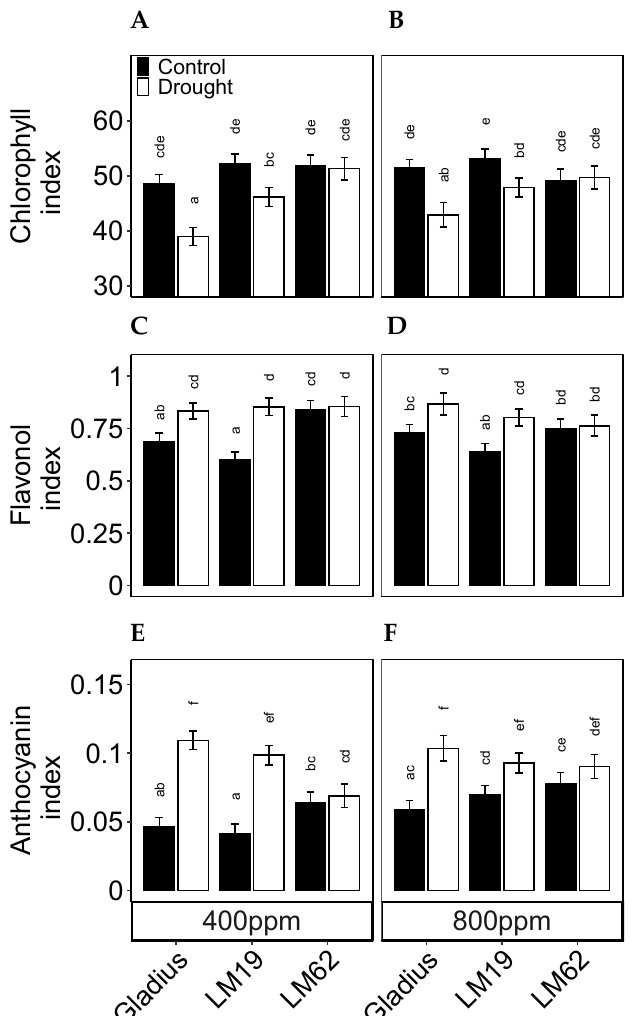
Figure 5. Pigment contents measured as Dualex indices. ( A , B ): chlorophyll, ( C , D ): flavonol and ( E , F ): anthocyanin index of flag leaf of three spring wheat genotypes (Gladius, LM19 and LM62) under well-watered conditions (Control) or affected by drought (Drought), at aCO 2 (400 ppm: ( A , C , E )) or eCO 2 (800 ppm: ( B , D , F )). Values represent mean ± SE ( n = 8–16). Values that share a letter are not significantly different according to Tukey’s honestly significant test ( p < 0.05).